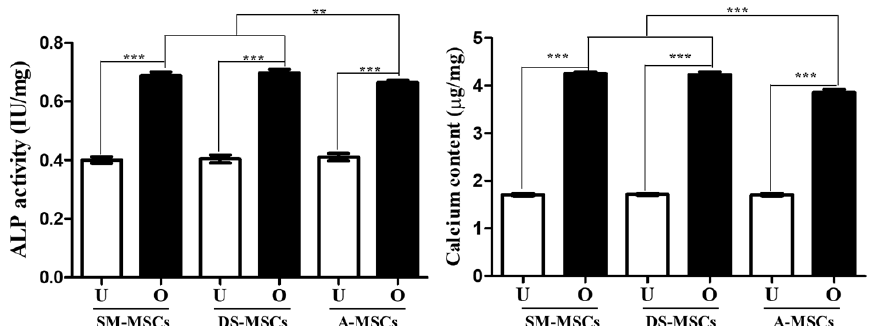
Figure 6. The levels of alkaline phosphatase (ALP) activity and calcium content of MSCs derived from skeletal muscle (SM-MSCs), dermal skin (DS-MSCs), and adipose tissue (A-MSCs). The differentiated osteoblasts from SM-MSCs and DS-MSCs showed significantly ( p < 0.05) increased the ALP activity (day 7) and calcium content (day 21) compared to that from A-MSCs. Data are represented by the mean ± SD of four independent experiments. Asterisks indicate significant difference between the undifferentiated cells and differentiated cells (** p < 0.01; *** p < 0.001). White bar: undifferentiated cells; black bar: differentiated cells; U: undifferentiated cells; O: osteogenic differentiated cells.